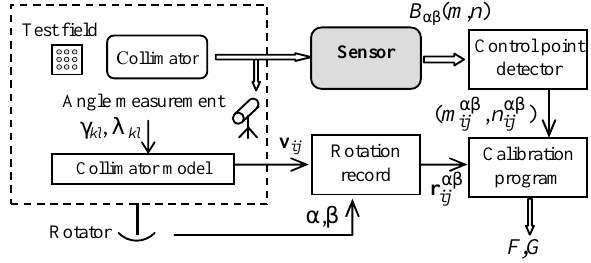
Figure 1. Circuit of the geometrical calibration